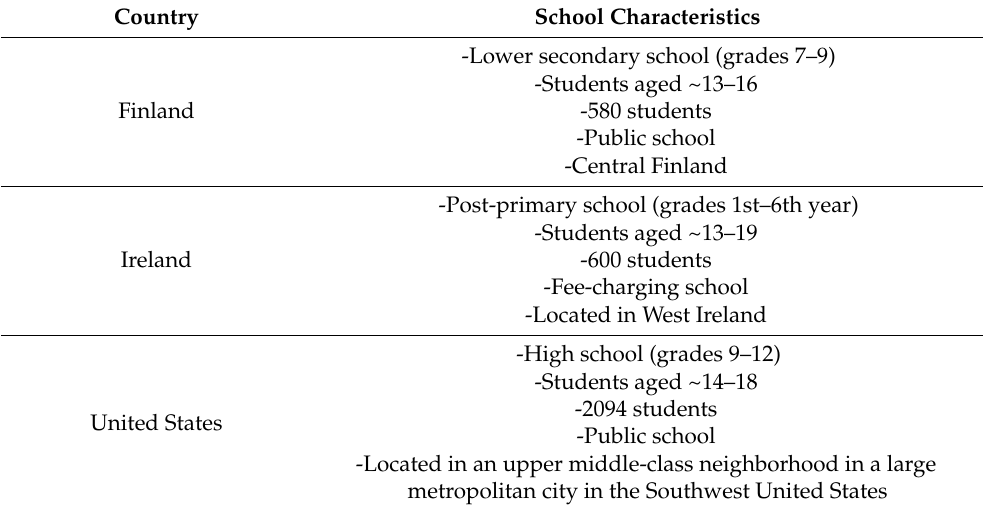
Table 1. School information by